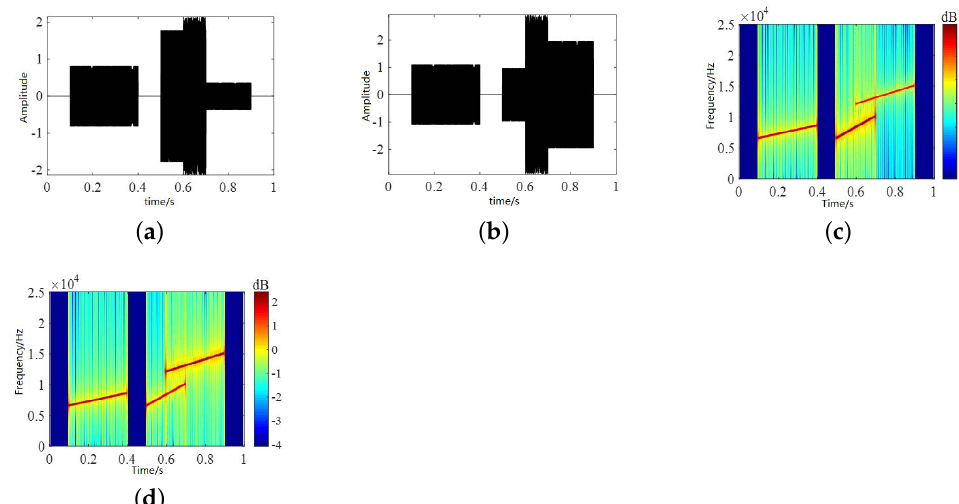
Figure 6. Time-domain waveforms and time–frequency diagrams for source signals. ( a , c , e ) show the time-domain waveforms of the three signals and ( b , d , f ) show the time–frequency diagrams for the three signals.